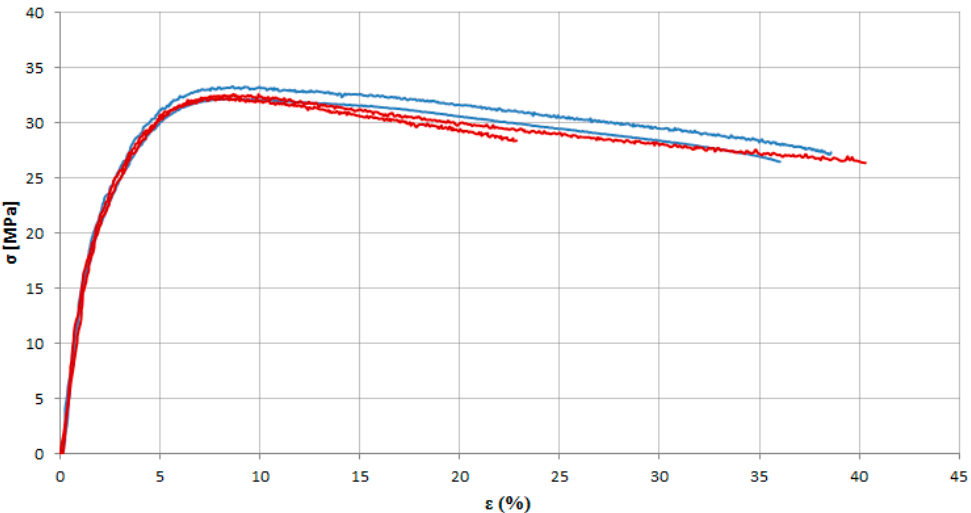
Figure 16. Stress–strain curves obtained from uniaxial tensile tests performed in the biaxial testing machine on MEB (horizontal axis—blue curves; vertical axis—red curves).